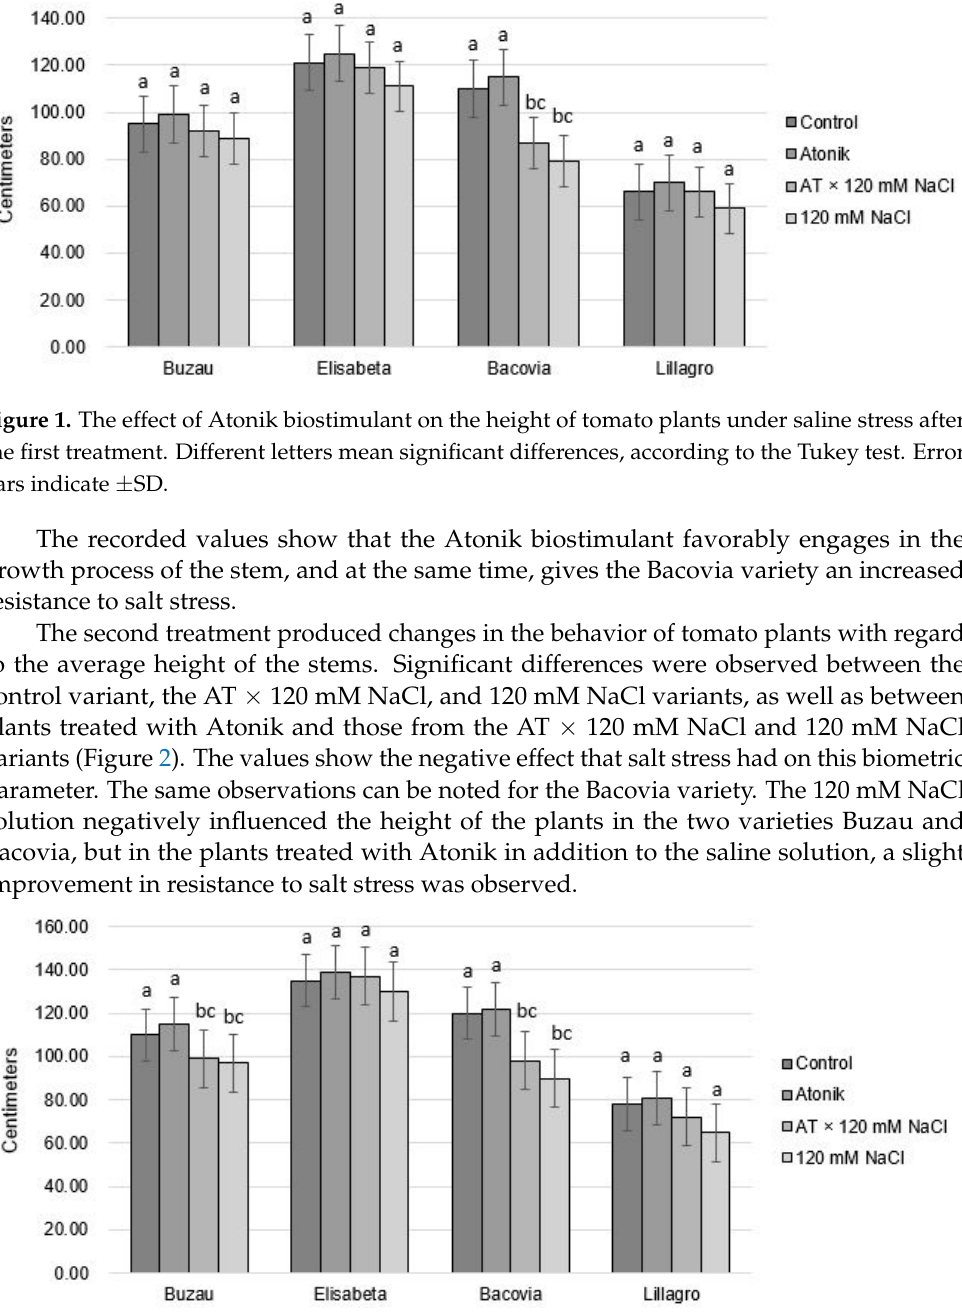
Figure 2. The effect of Atonik biostimulant on the height of tomato plants under saline stress after the second treatment. Different letters mean significant differences, according to the Tukey test. Error bars indicate ±SD.